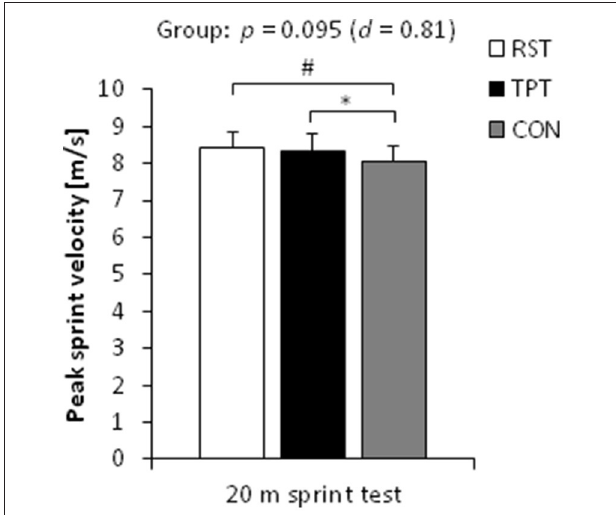
FIGURE 2 | Baseline-adjusted post-test means and standard deviations of peak sprint velocity during the 20m linear sprint in the resisted sprint training (RST) group, traditional power training (TPT) group, and control (CON) group. * p < 0.05, # p <